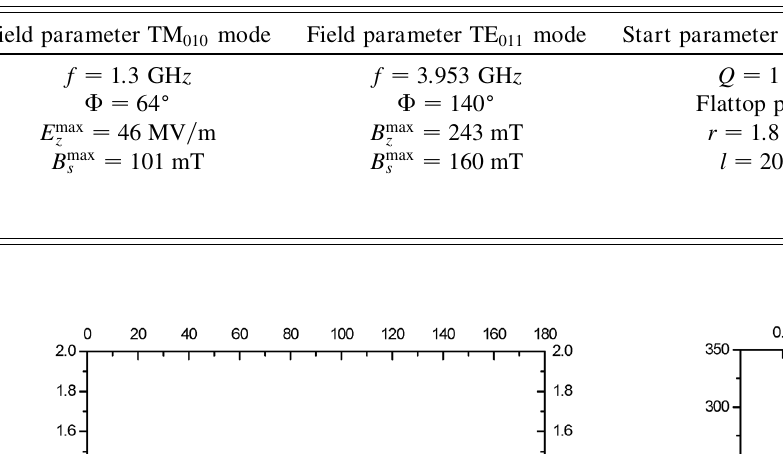
II. Optimal rf and beam parameters for a superconducting rf gun with an additional magnetic rf field inside the cavity. The amplitude of the magnetic surface field is below the quench